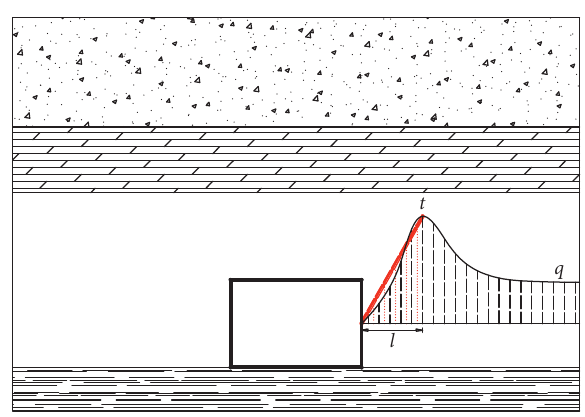
Figure 1: The vertical stress distribution of roadway sides.